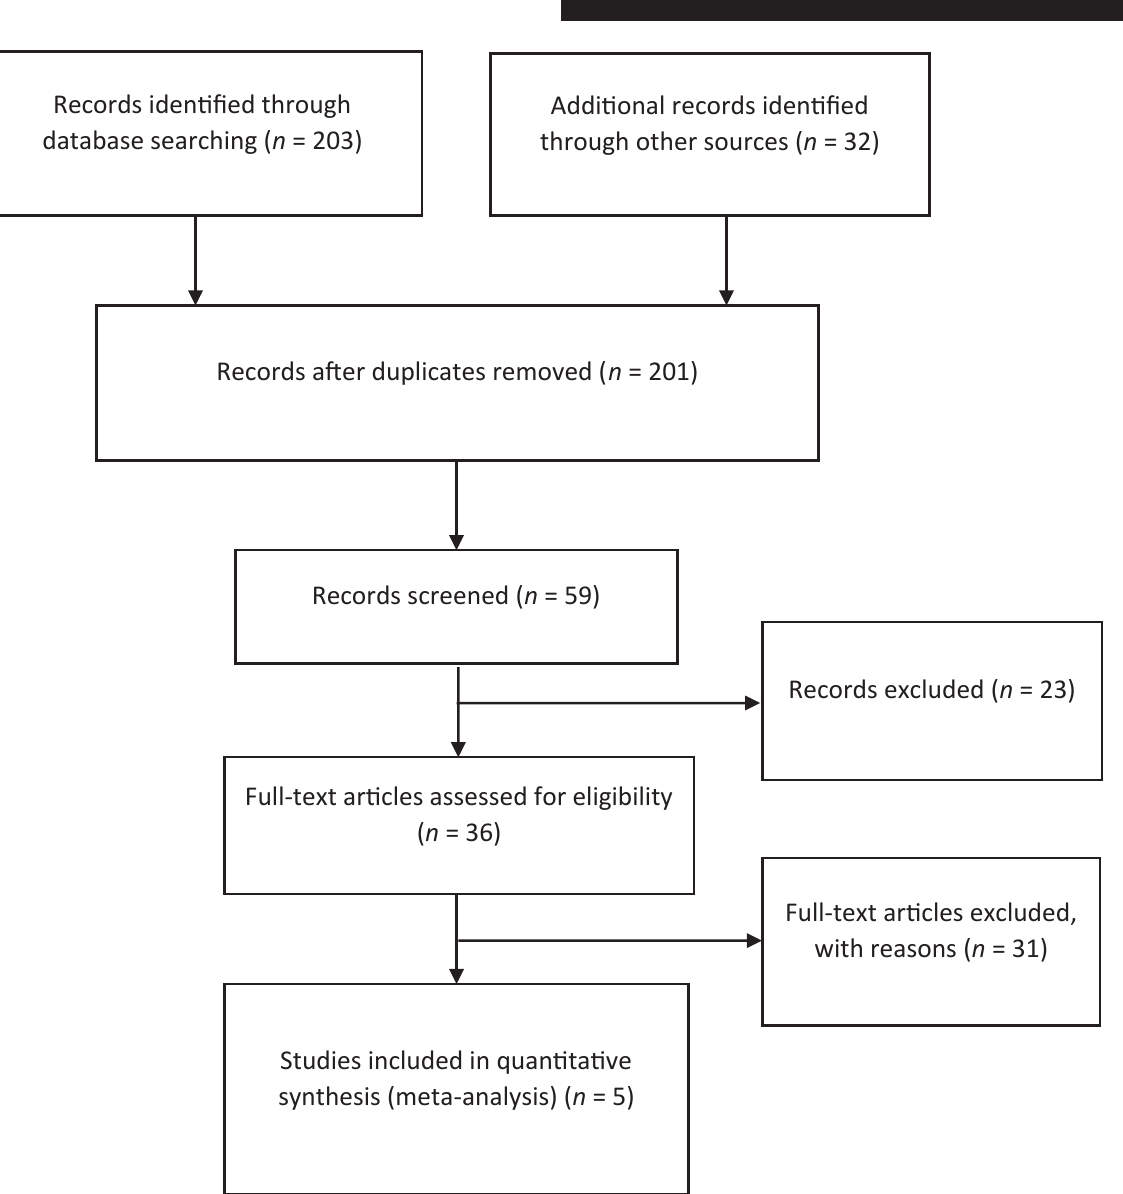
Figure 1. Flow of studies through the review